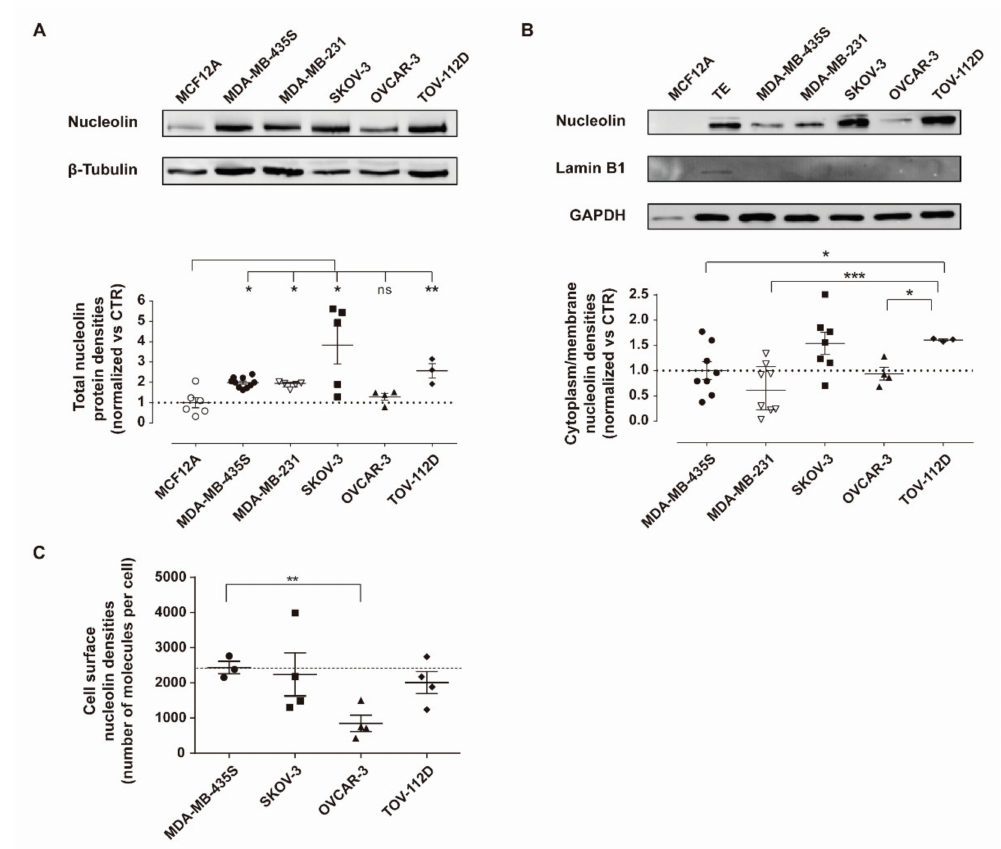
Figure 1. Nucleolin expression density in ovarian cancer cell lines. Quantification of nucleolin protein densities in ( A ) total extracts and ( B ) cytoplasm/membrane extracts was performed by immunoblotting in ovarian cancer cell lines SKOV-3, OVCAR-3 and TOV-112D, as well as triple-negative breast cancer MDA-MB-231, nucleolin-overexpressing MDA-MB-435S and non-tumorigenic MCF12A cells, used as controls. ( C ) Cell surface nucleolin density was quantified by flow cytometry in the indicated cell lines. Data represent mean ± SEM ( n = 3 unpaired t test with Welch’s correction; ns p > 0.05, * p < 0.05, ** p < 0.01 *** p < 0.001). TE = total extract; control (CTR) = β -tubulin or GAPDH. Whole Western Blots images can be found in Figure S5.